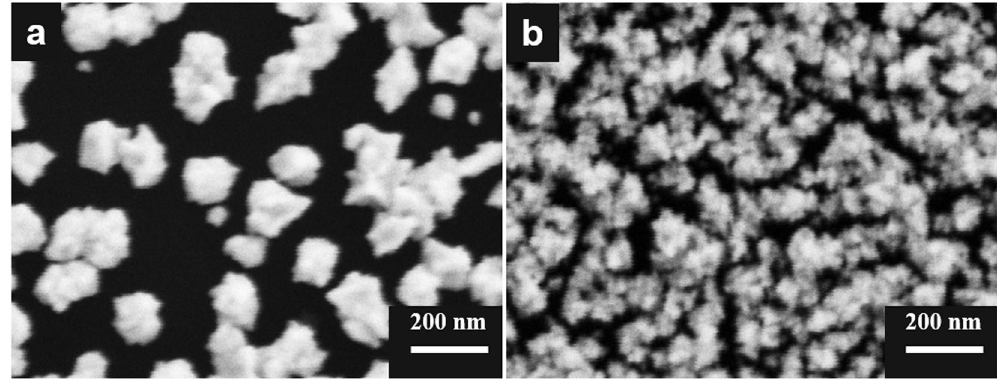
Figure 8. FESEM images of prepared AuPt nanoparticles under different applied potentials: ( a ) − 0.70 V and ( b ) − 2.00 V vs .